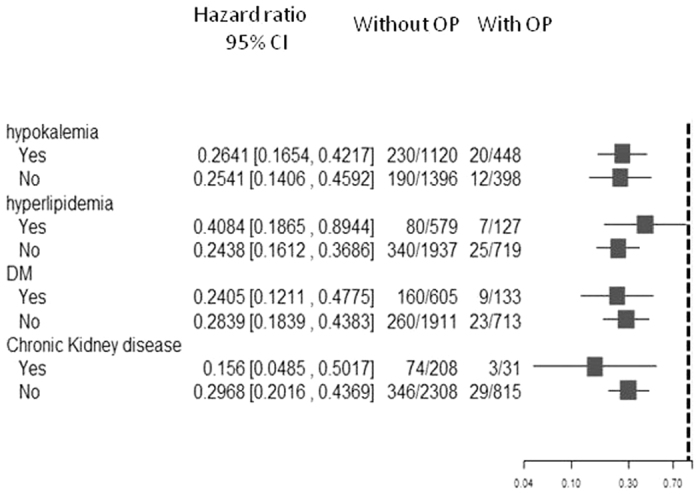
Adjusted HRs for long-term risk of mortality among PA patients, based on comparison between adrenalectomy and non-adrenalectomy groups, and subgroup analysis with respect to premorbid risk that further adjusted for age and gender.(Abbreviations: CI, confidence interval; DM, diabetes mellitus; HR, hazard ratio; OP, operation; PA, primary aldosteronism).